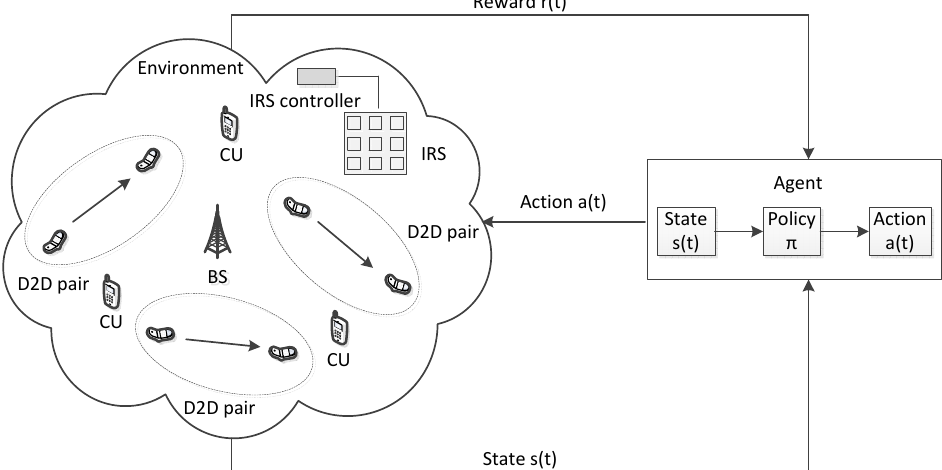
Figure 2. The RL framework for the IRS-assisted D2D communication